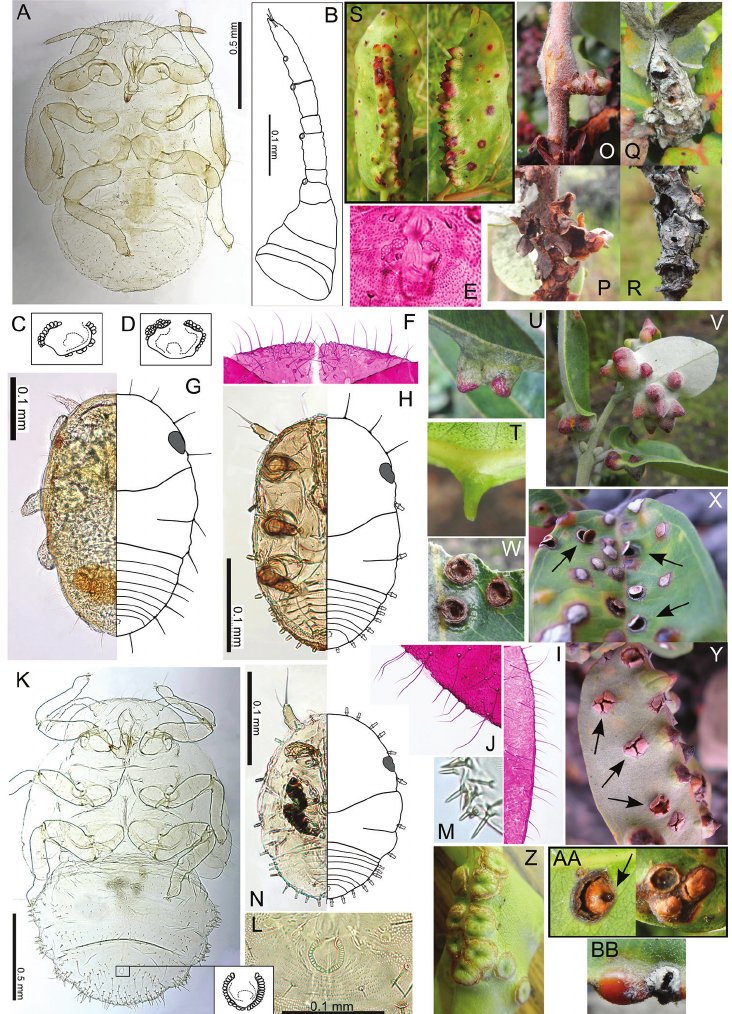
Figure 52. Pariaconus hawaiiensis , Pariaconus pele and Pariaconus pyramidalis immatures. A–C P. ha- waiiensis : A 5 th instar B antenna C anal ring D–I P. pyramidalis : D, E anal ring (E stained) F detail of marginal simple setae (head, stained) G 2 nd instar H 1 st instar I detail of marginal simple setae (wing pad, stained) J P. hawaiiensis , detail of marginal simple setae (wing pad, stained) K–N P. pele : K 5 th instar with anal ring detail (inset) L anal ring M detail of marginal simple setae N 1 st instar O–R P. hawai- iensis : examples of developing and older necrotic and lignified stem and bud galls S–W P. pyramidalis : cone galls on glabrous host morphotypes clustered along the leaf mid-vein T detail of narrow cone gall produced on glabrous host morphotype U, V broad cone galls produced on more pubescent host mor- photypes W scars remaining on upper leaf surface from old cone galls X–Y single leaf with both P. pele and P. pyramidalis galls: X upper leaf surface with cone galls opening by hinged circular door (indicated) Y lower leaf surface with flat galls opening by valves (indicated) Z donut-type gall with central depression produced by P. pele form kohalensis AA–BB P. pele gall variations: AA gall with central plug (indicated), opening with circular suture BB gall produced on the leaf